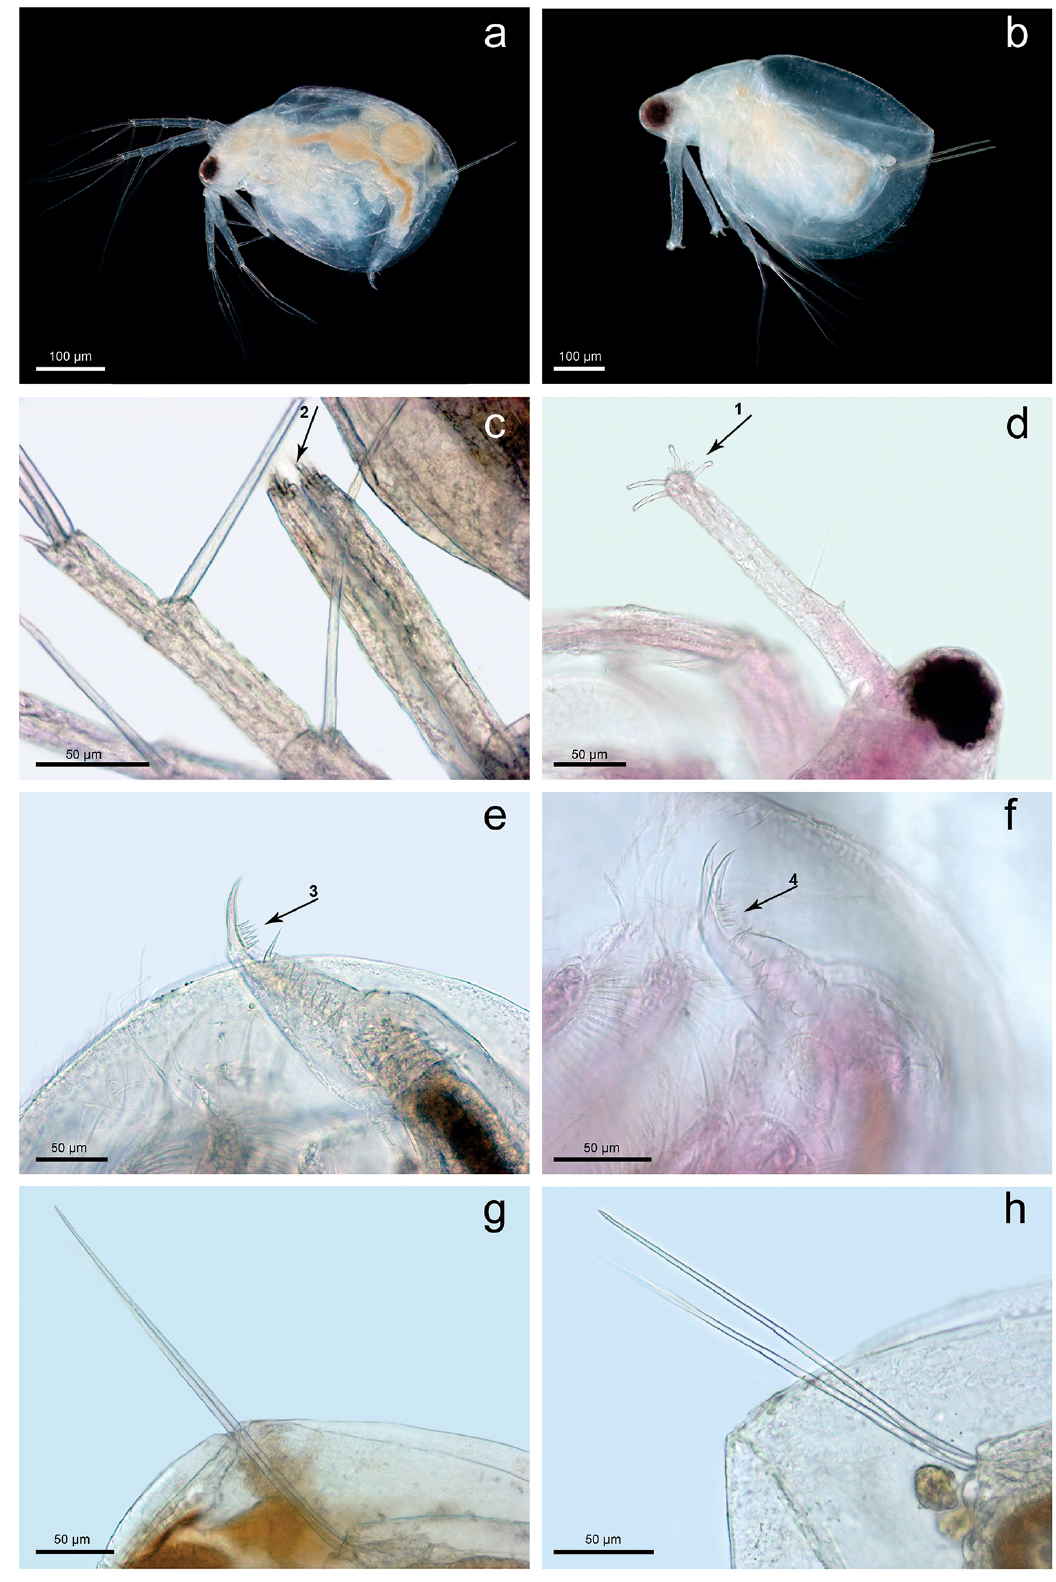
Figure 2. Specimens of female ( a, c, e, g ) and male ( b, d, f, h ) of Moina dumonti Kotov, Elías-Gutiérrez and Granado-Ramírez, 2005 from Camucim Forest Protected Area, Pernambuco, Brazil. a , Parthenogenetic female; b , male; c , antenna I, aesthetasc of similar size (Arrow-2 setae); d , antenna I, Arrow-1 points to four hook-like setae; e , postabdomen (Arrow-3: set of teeth - n: 5); f , postabdomen (Arrow-4: set of teeth - n: 4); g, h , back of the dorsal valve of female and male,